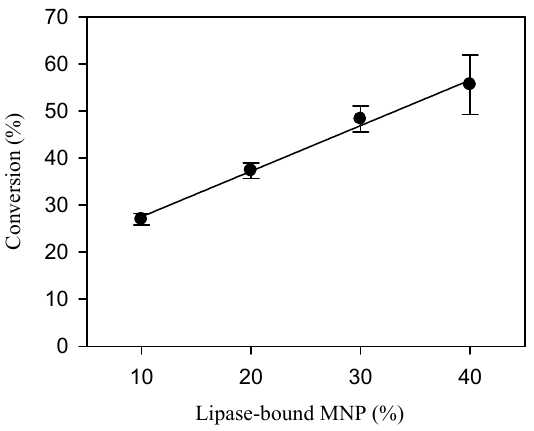
Figure 2. Effects of dosage of lipase-bound magnetic nanoparticles (MNP) on the conversion of fatty acid methyl esters (FAME). The dosage was expressed in weight percentage of waste cooking oil. The reaction was carried out at 40 °C for 72 h with water content of 10% ( w / w of oil). The molar ratio of methanol to oil was 3:1; three separate additions at 0, 24 and 48 h, one third of the total amount each time. The equation of the fitted line is y = x + 17.8 with R 2 =